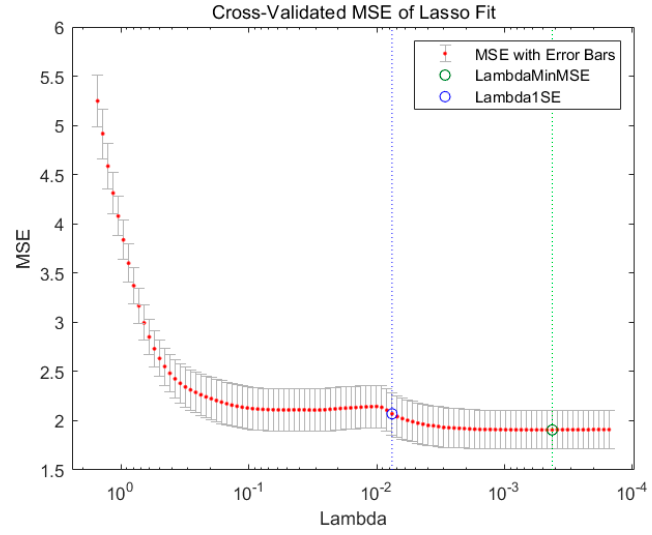
Figure 5. Feature classification weight diagram after threshold setting. ( a ) Upper submap: Feature weight value map; ( b ) Lower submap: Weight value frequency chart.